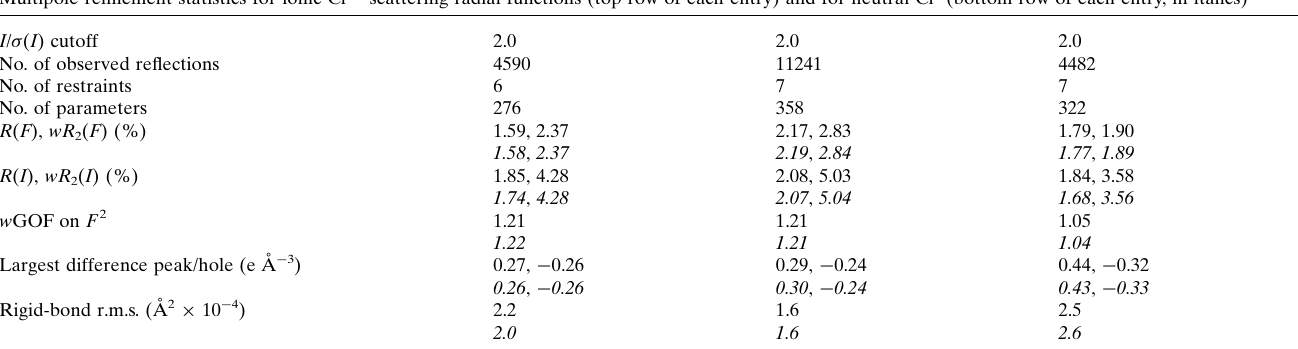
Multipole refinement statistics for ionic Cl (cid:4) 1 scattering radial functions (top row of each entry) and for neutral Cl 0 (bottom row of each entry, in italics) I / (cid:6) ( I )